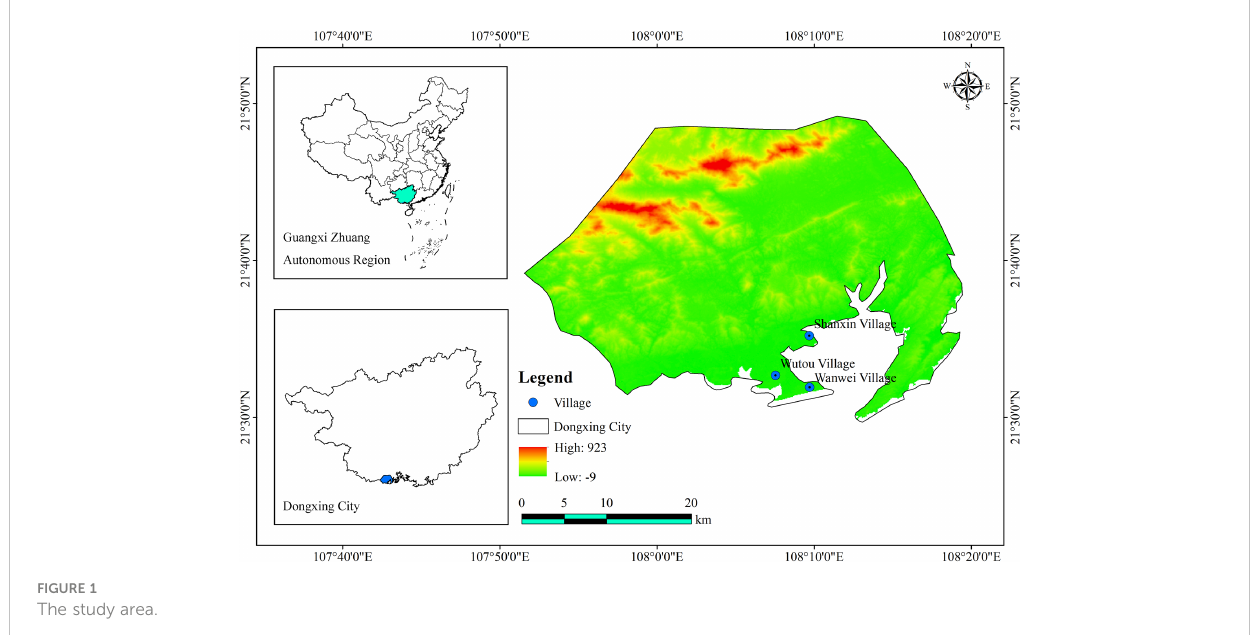
FIGURE 1 The study